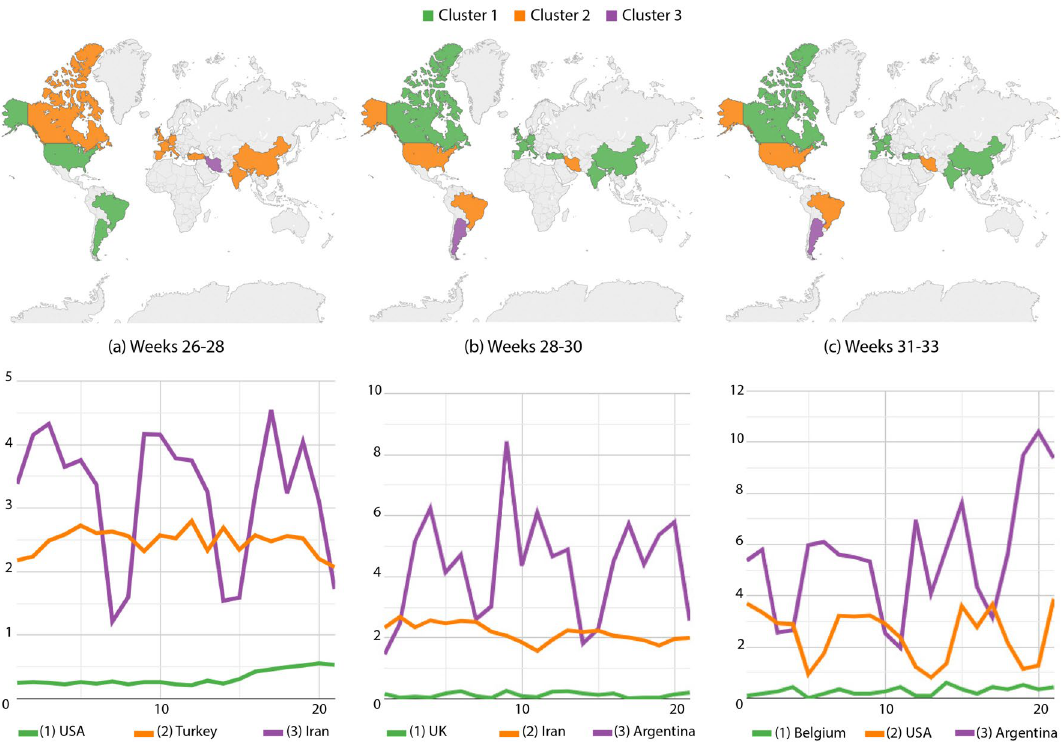
Figure 8. Death cases per million inhabitants: country partitions along weeks 26–33. Top images identify country groups and bottom curves correspond to the infection incidence levels: green, orange and purple correspondingly map the low, medium and high-incidence groups. Curve legends indicate the group descriptor. Top-most maps were generated by using Tableau Desktop-Professional Edition (https:// www. table au. com/, version 20181.20.0213.2110-64 bit), and bottom-most charts were generated by using Google Charts (https:// devel opers. google. com/ chart, version 49).